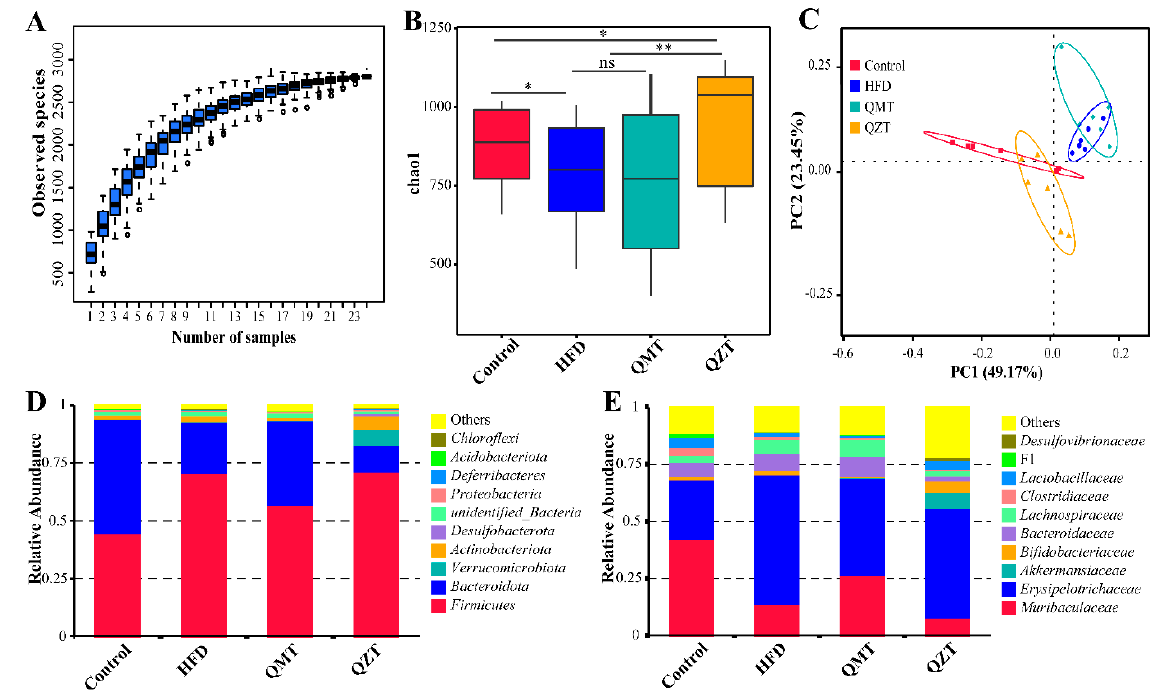
Figure 3. Effects of QMTe and QZTe supplementation on HFD-disrupted gut microbiota composition. ( A ) The species accumulation boxplot. ( B ) chao1 index of gut microbiota in each group of mice. ( C ) PCoA based on OTU relative abundance. Each point represents the composition of gut microbiota in one group. Bacterial taxonomic profiling at the phylum ( D ) and family ( E ) level. F1, Eubacterium _ coprostanoligenes _group.